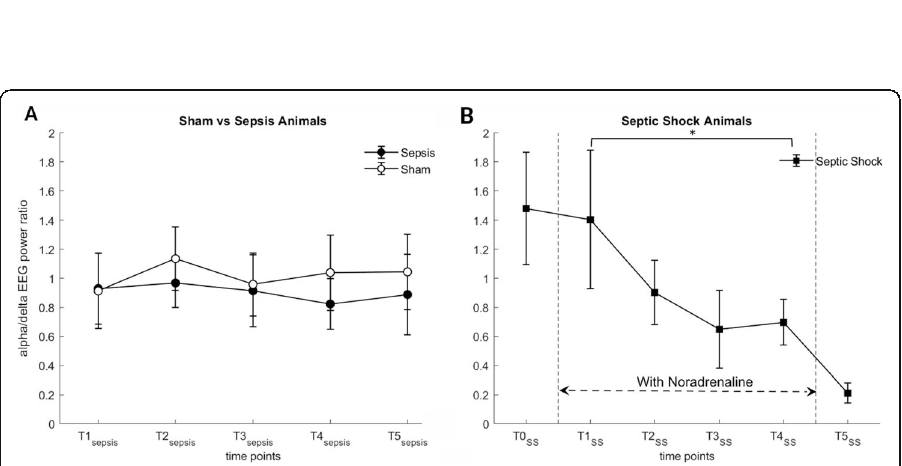
Fig. 4 Temporal evolution of cortical activity during experimental sepsis. Alpha/delta ratio of the ECOG signal in sepsis vs. sham ( a ) and septic shock ( b ) group. No difference is observed in the sepsis and sham groups. There is a significant decrease in ADR in the septic shock group between T1 SS and T4 SS . Data are presented as median ± mean absolute deviation; * p <